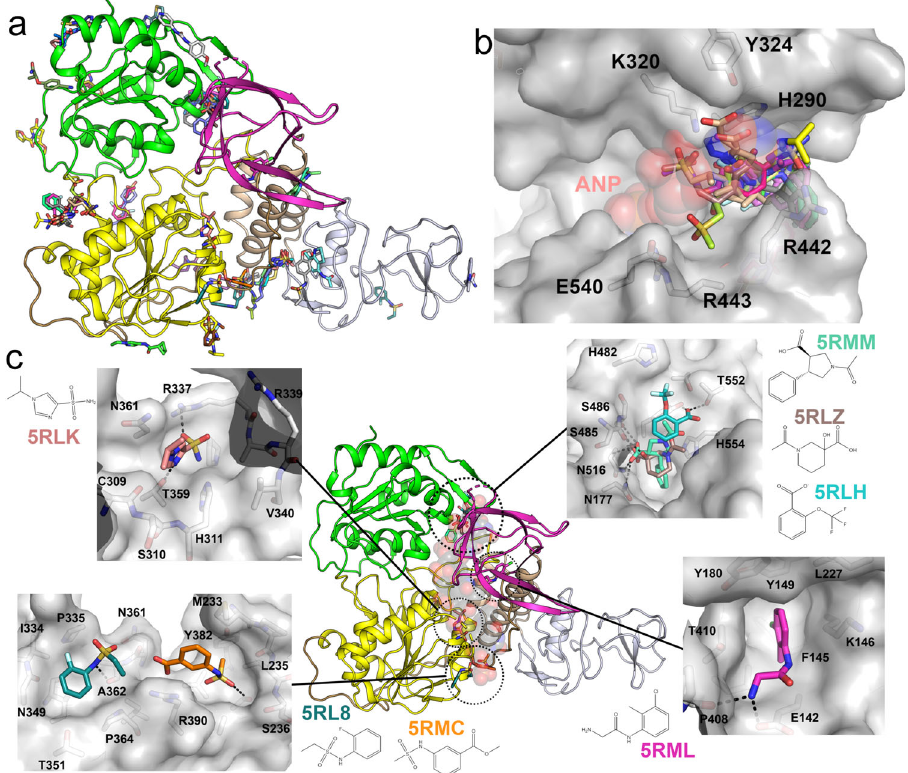
Fig. 4 Fragments bound to NSP13 in the nucleotide and RNA binding interfaces. a Overall view of all fragments bound to NSP13. b Close-up view of the 15 fragments identi fi ed in the nucleotide binding site. The AMP-PNP moiety (ANP) is shown in a semi-transparent sphere representation for reference. c Overview of the fragments bound to the NSP13 RNA interface. The main panel shows the positioning of the clusters with the RNA shown in a semi- transparent sphere representation for reference. Each binding interface is shown in the inset in a detailed surface view with polar contacts shown in